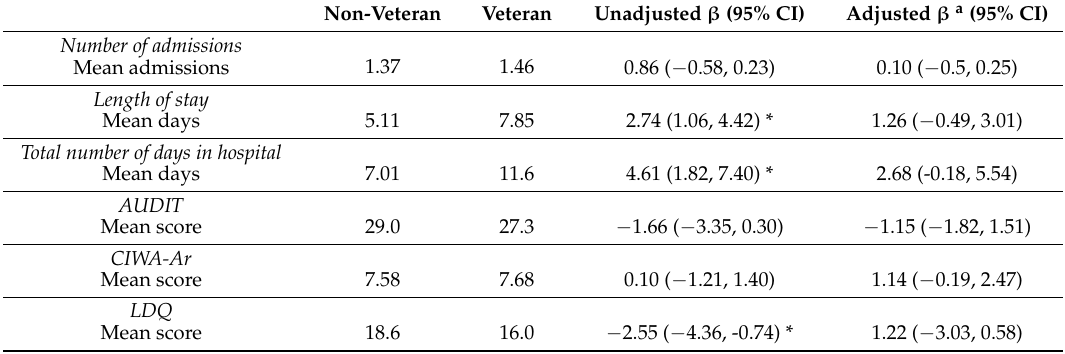
Table 2. Comparison of service utilisation and alcohol presentation between veterans and